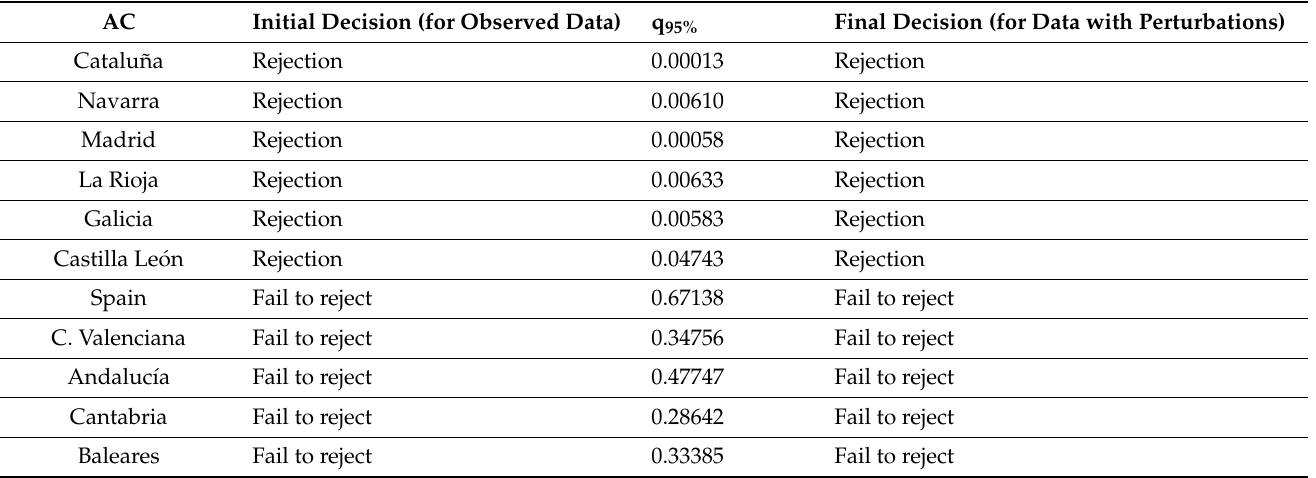
Table 3. Showing the sensitivity analysis results for each